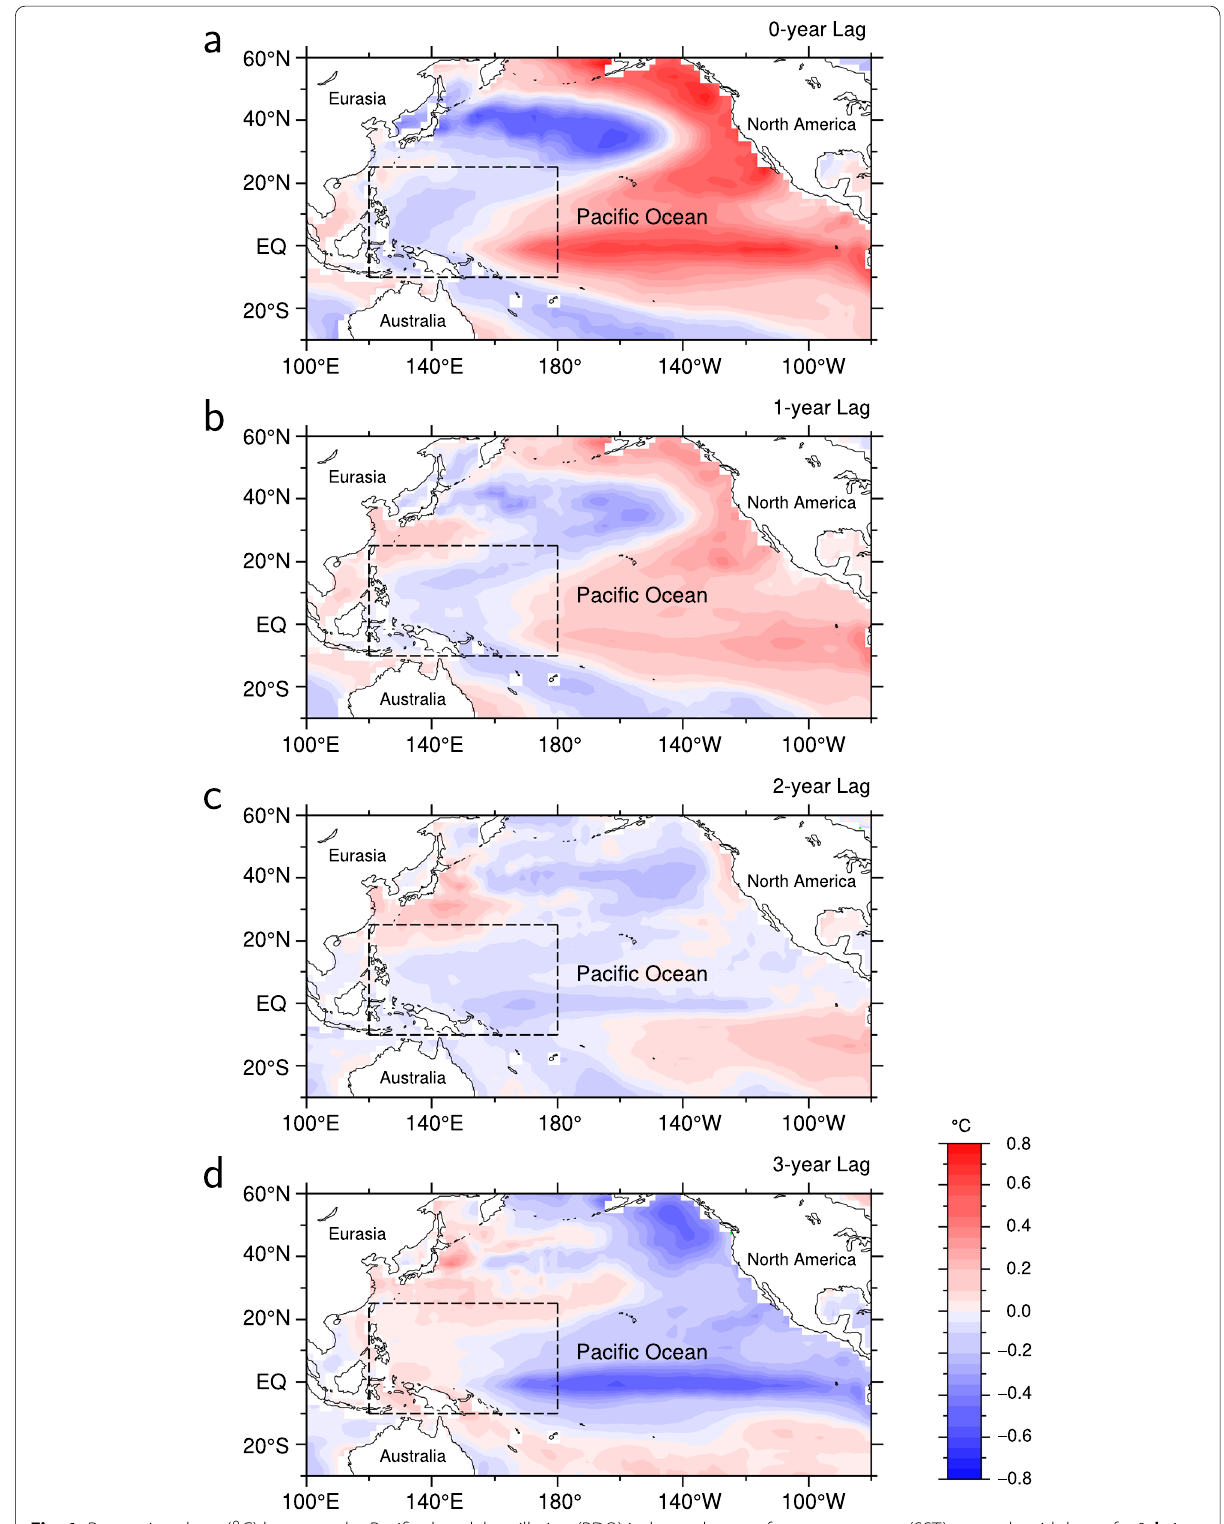
Fig. 1 Regression slope ( ◦ C) between the Pacific decadal oscillation (PDO) index and sea surface temperature (SST) anomaly with lags of a 0, b 1, c 2, and d 3 years. Dashed square shows the study region of this